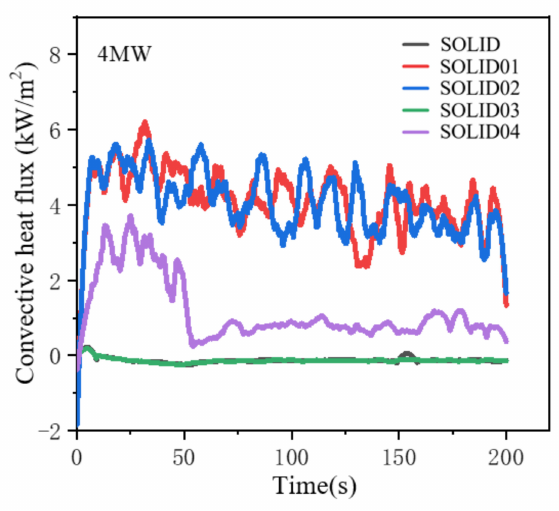
Figure 23. Variation of convective heat flux of glass under window sprinkler conditions.